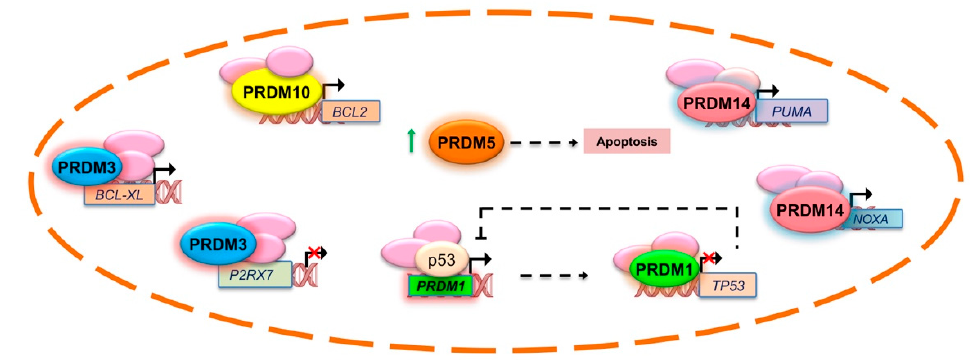
Figure 2. PRDM proteins action in the regulation of apoptosis genes expression. Although the precise and direct involvement of PRDMs in apoptosis is not completely unravelled, it is established that they are able to control the expression of several genes participating in this biological process, like BCL-XL , BCL2 , and TP53 among the others. This scheme illustrates the regulation of apoptotic genes by PRDMs where a direct link was demonstrated (see text for additional details).